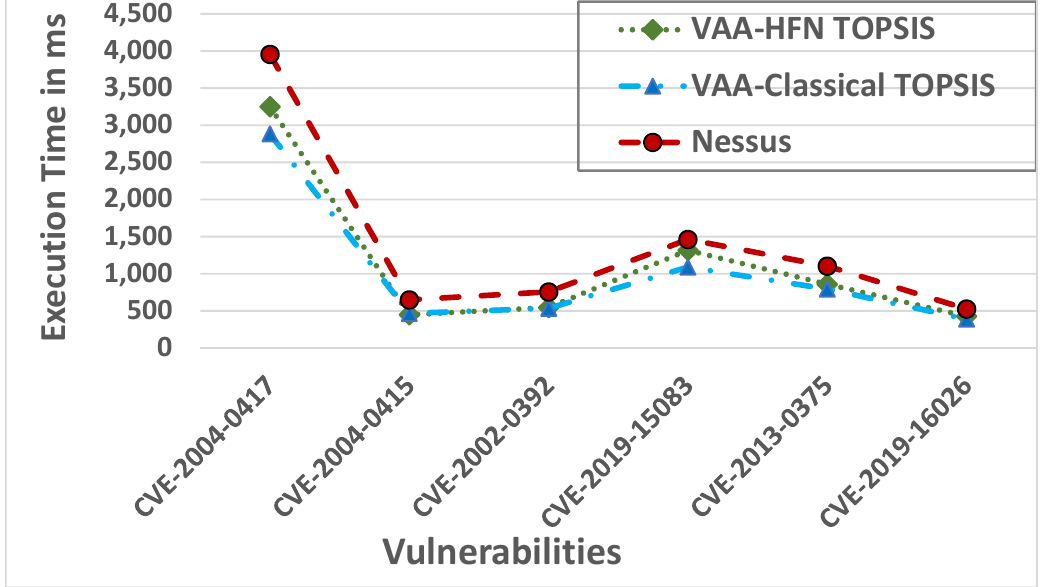
Figure 13. Execution time of the VAA and Nessus.